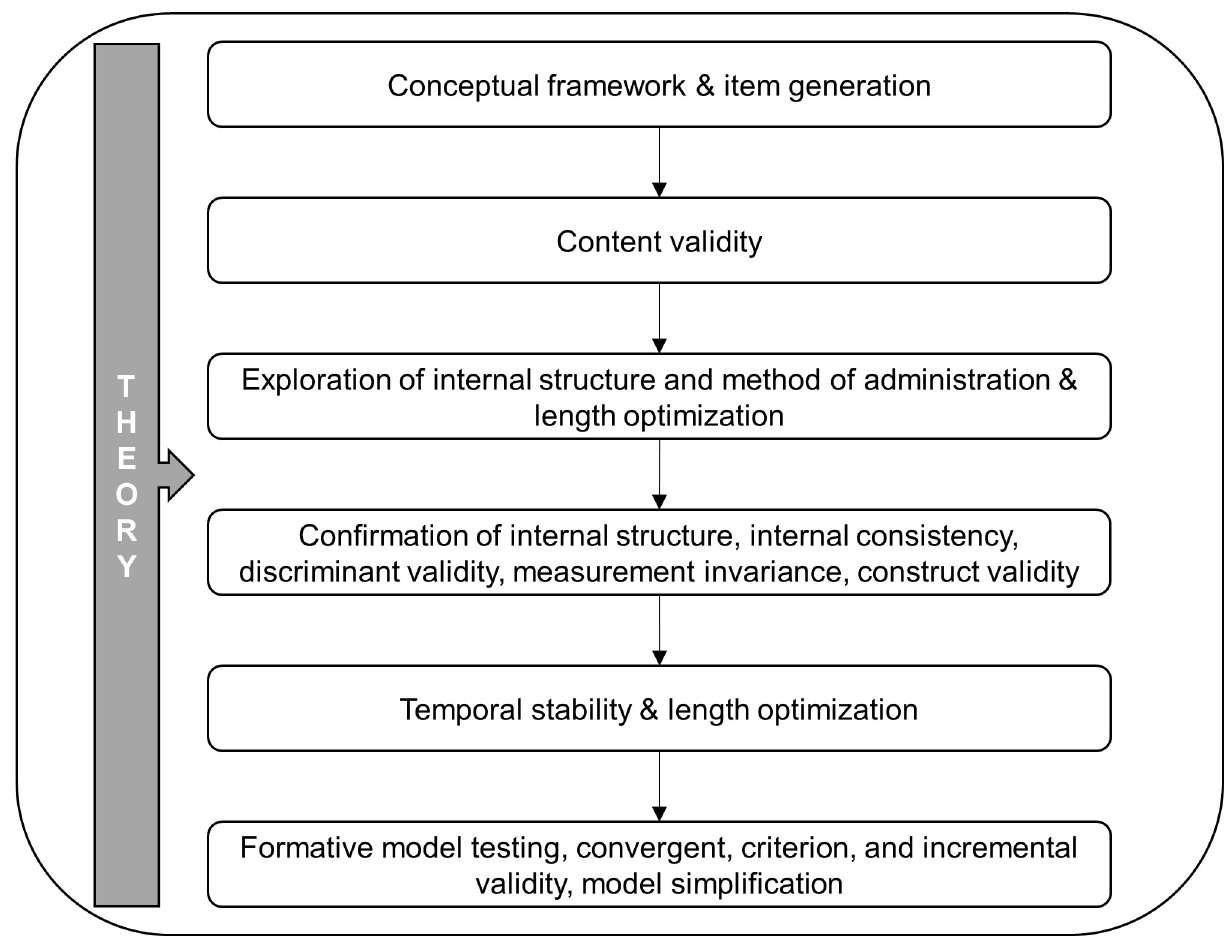
Fig 1. Steps in the development and validation of